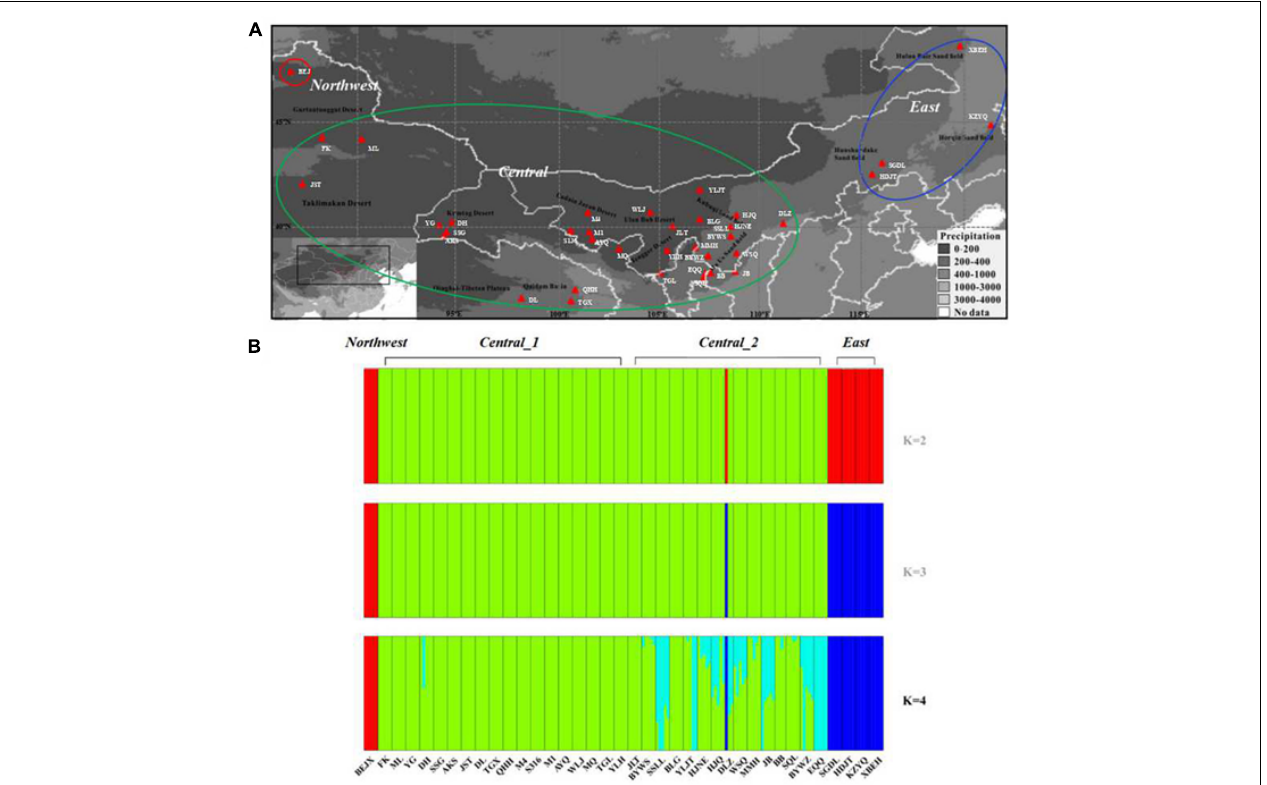
FIGURE 1 | Geographic distribution and genetic clusters of the 38 sand rice populations used in this study. (A) Geographic distribution of the sampled sand rice populations. Populations in the red circle represent the populations were grouped into the Northwest lineage, populations in the green circle represent the populations were grouped into the Central lineage, populaitons in the blue circle represent the populations were grouped into the East lineage. (B) Population structure of the 38 sand rice populations inferred using FastStructure, based on neutral